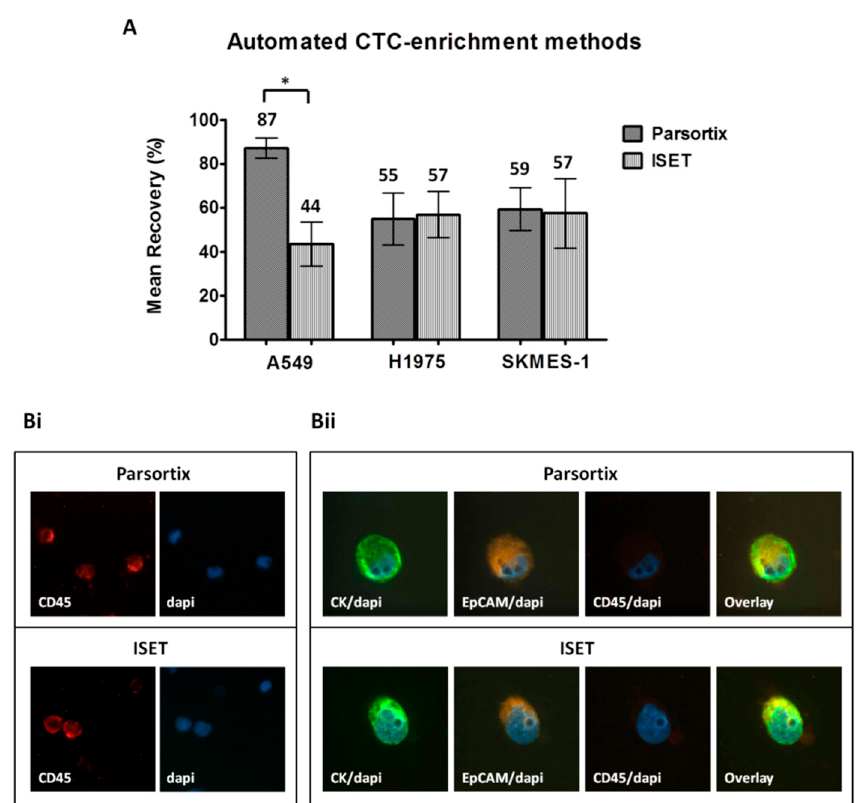
Figure 3. Comparison of the automated CTC ‐ enrichment systems Parsortix and ISET in spiking experiments: Three representative non ‐ small cell lung cancer (NSCLC) cell lines, A549, H1975, and SKMES ‐ 1, were used. ( A ) Recovery rates following enrichment by using Parsortix and ISET. Values represent mean recoveries; ± SEM (error bars). * Two ‐ sided t ‐ test; statistical significance observed at the p < 0.05 level. ( B ) Representative staining of DAPI / CD45 staining on PBMC (i) and of DAPI / CK / epithelial cell adhesion molecule EpCAM / CD45 staining on spiked H1975 cells (ii) enriched by the two methods (Ariol microscopy system, Genetix, New Milton, UK) (400 ×).